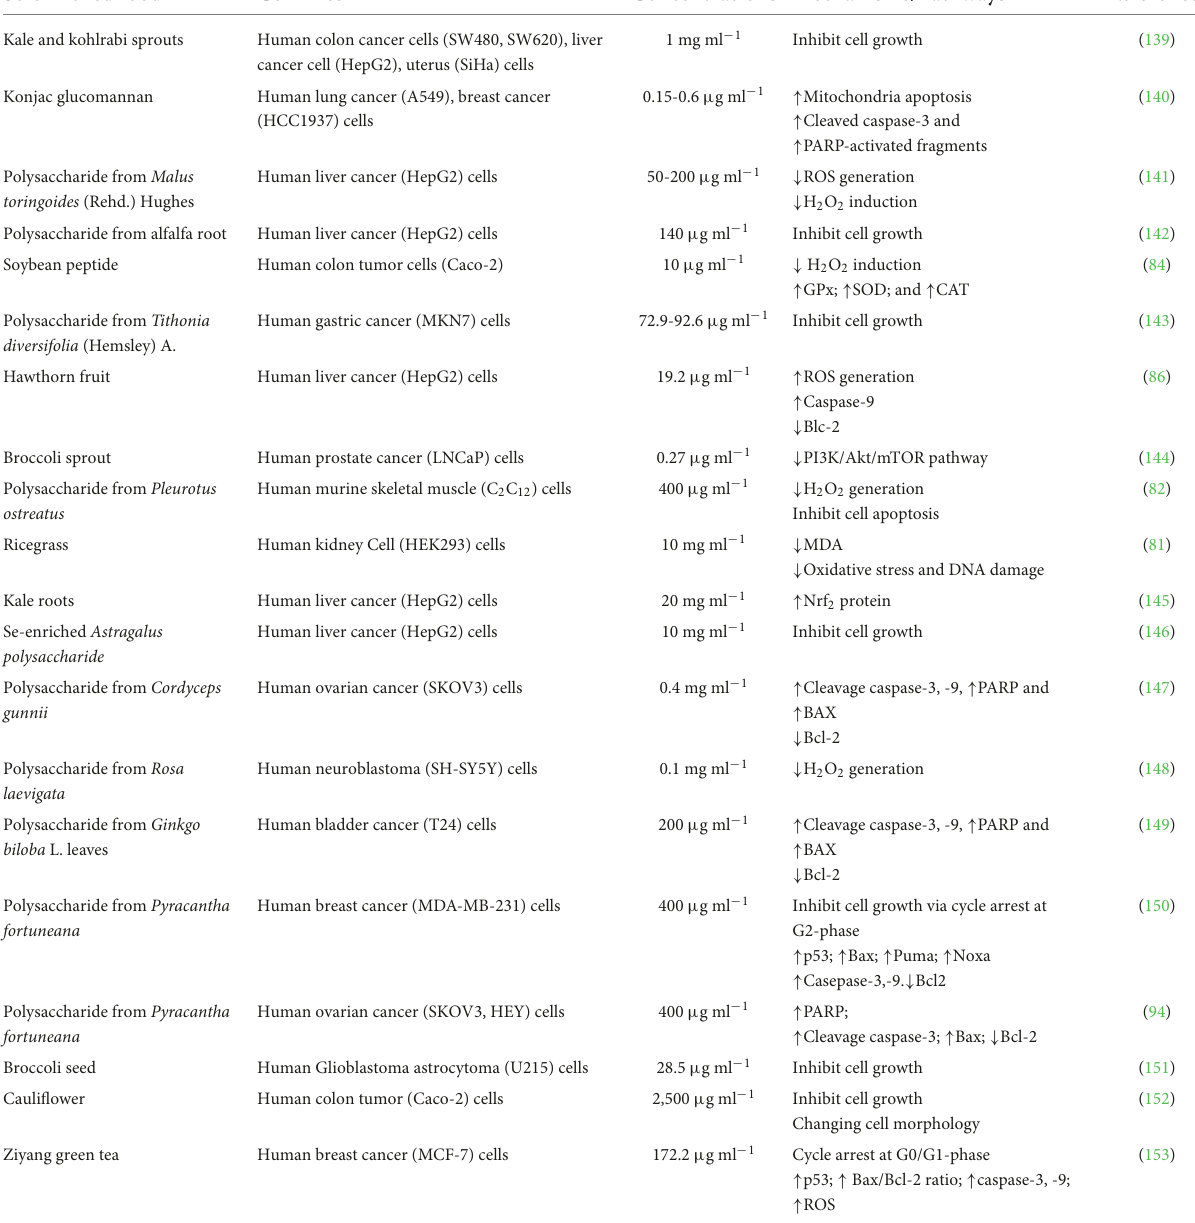
TABLE 2 In vitro studies of Se-enriched plant foods against human cell lines. Se-enriched